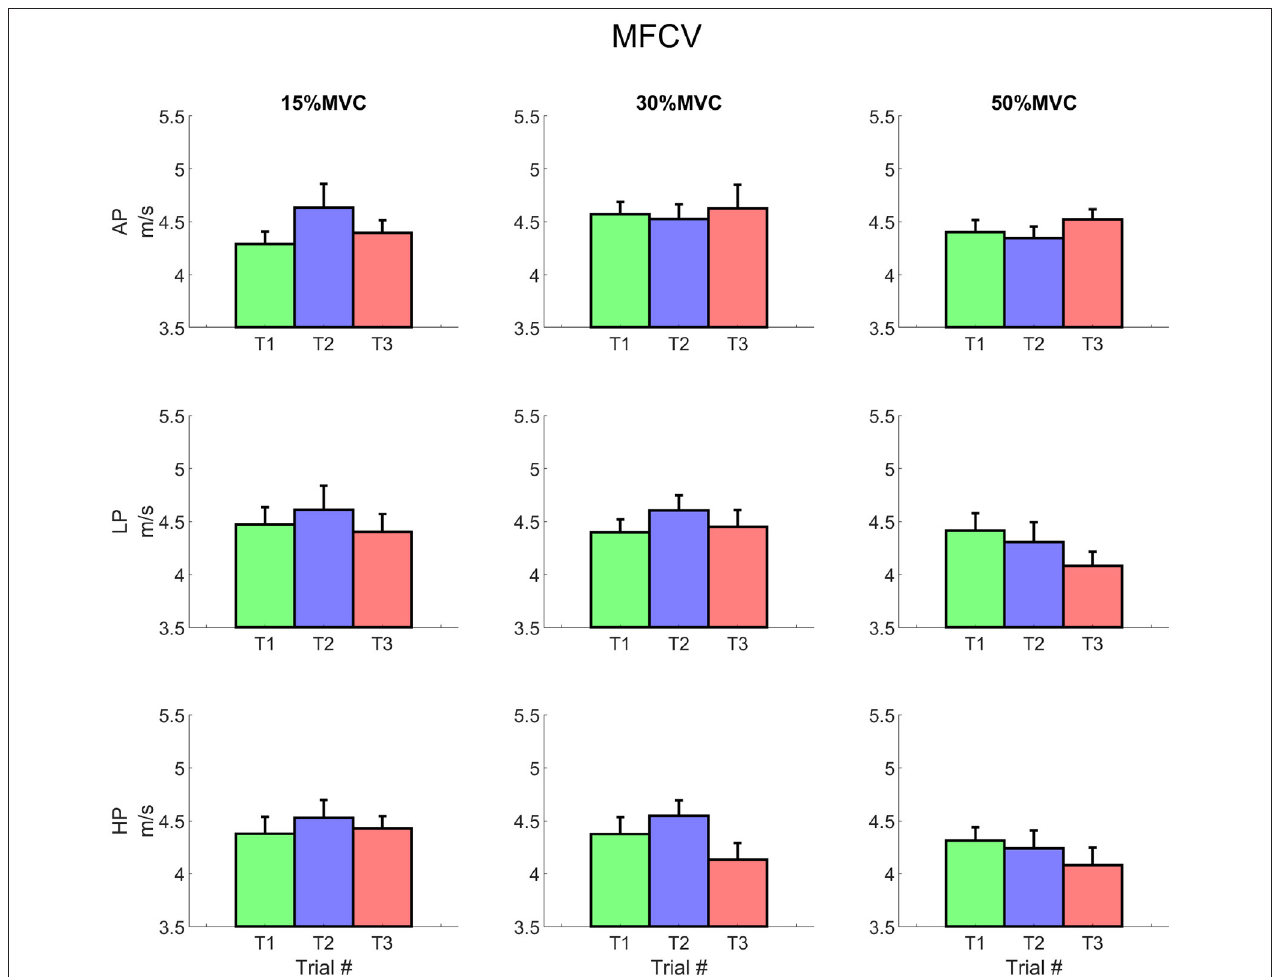
FIGURE 8 | Average muscle fibres conduction velocity for each condition. It is possible to notice a decrease in the MFCV, which is most remarkable at trial 3 for 30 and 50% MVC for LP and for both LP and HP, respectively. Rows represent different levels of pressure, columns, different levels of torque. The data is represented as average and standard error across all the subjects for the three repetitions of the task. Trial 1 is represented in green, trial 2, in blue, and trial 3, in